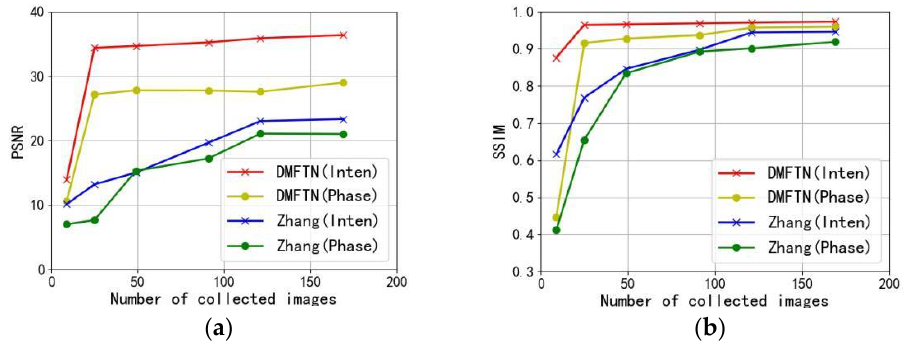
Figure 12. Reconstruction quality curve with reduced number of acquired images: ( a ) PSNR plot of